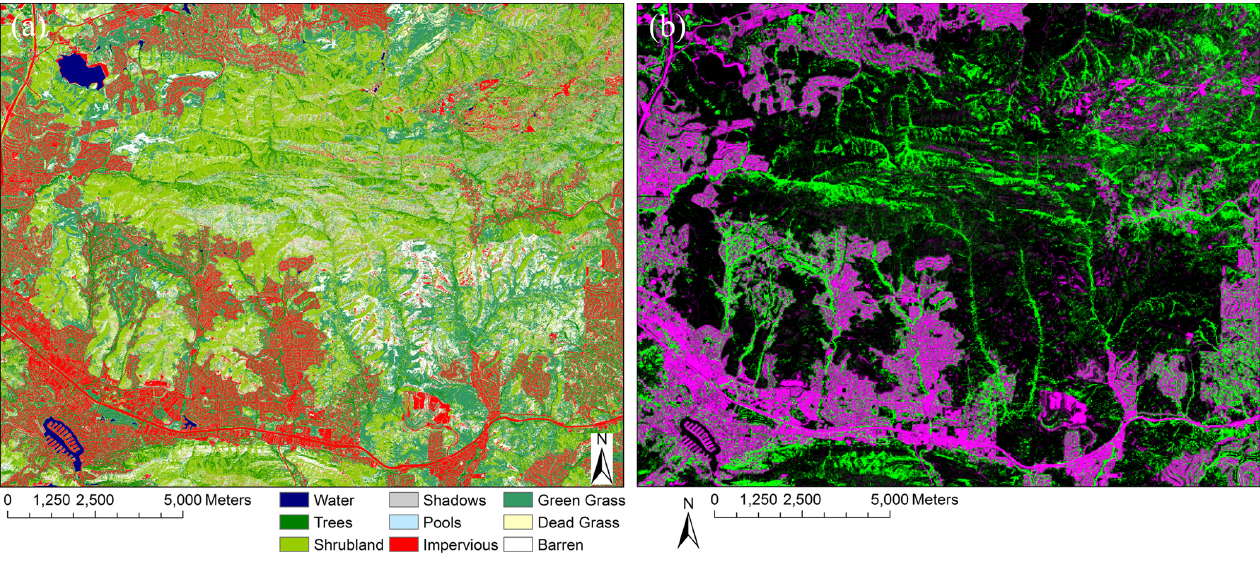
Fig. 4 . (a) Land cover classification and (b) the percentage of trees (green) and the percentage of impervious surface (purple) for the Santa Monica Mountains National Recreation study area. Higher percentages of trees correspond with development, riparian corridors, and north-facing slopes. High impervious surfaces are found in residential areas in the south and west.